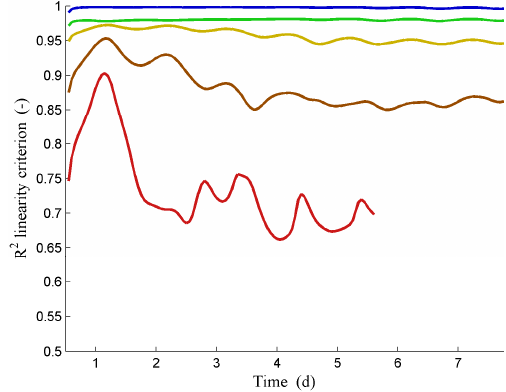
Fig. 7. Verification of the stability of K comp at different times of the “Equil” scenario (day 1 – red, day 2 – orange, day 3 – yellow, day 4 – green, day 5 – cyan – and day 6 – blue). Crosses were obtained from the explicit model while straight lines were predicted with the implicit model.